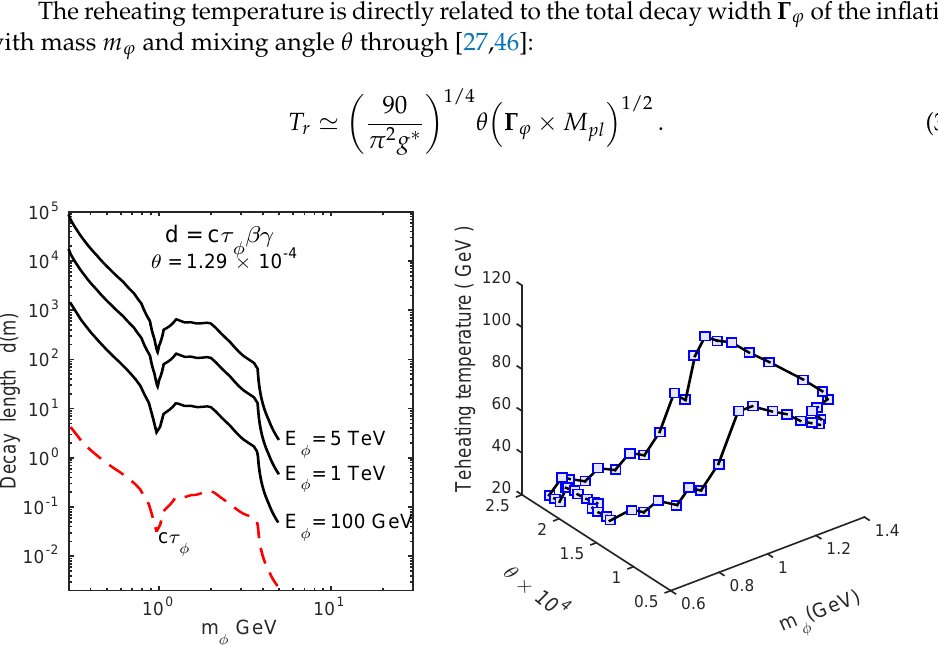
Figure 6. Left : The evolution with m ϕ of dark Higgs inflation decay length, d = c τ φ γβ , for various dark Higgs energies E ϕ and θ = 1.29 × 10 − 4 . Right : The estimated reheating temperature in dark Higgs parameter space